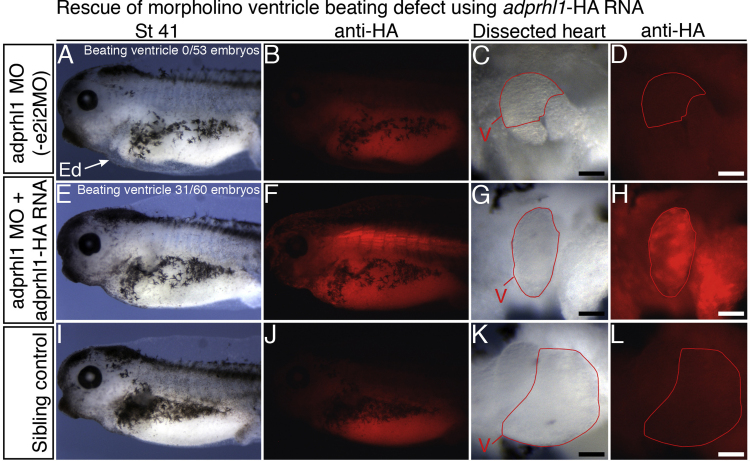
Rescue of morpholino ventricle beating defect using adprhl1 RNA. A–D: A tadpole injected with Adprhl1-e2i2MO into D-2/4 blastomeres, shown at stage 41. Left lateral (A, B) and ventral view of the dissected heart (C, D). E–H: A sibling tadpole co-injected with Adprhl1-e2i2MO and also adprhl1-HA RNA into D-2/4 blastomeres. The injection masses were 25 ng morpholino and 240 pg RNA. Immunological detection of HA-epitope gave a typical dorsal blastomere injection pattern (F) and signal in the ventricle of the dissected heart (H), which were absent in the tadpole injected solely with the morpholino (B, D). I–L: Comparable images of a sibling control tadpole. Red outlines show the position of the ventricle. The heart of the morpholino-injected tadpole was inactive, causing an oedema to form (A). The ventricle of the rescued tadpole was smaller than controls but actively contracted and no oedema developed (E). In this experiment, none of 53 tadpoles had a beating heart after injection of the morpholino while 31 out of 60 regained ventricular function with co-injection of adprhl1-HA RNA. Scale bars=100 µm. Ed, oedema; V, ventricle.